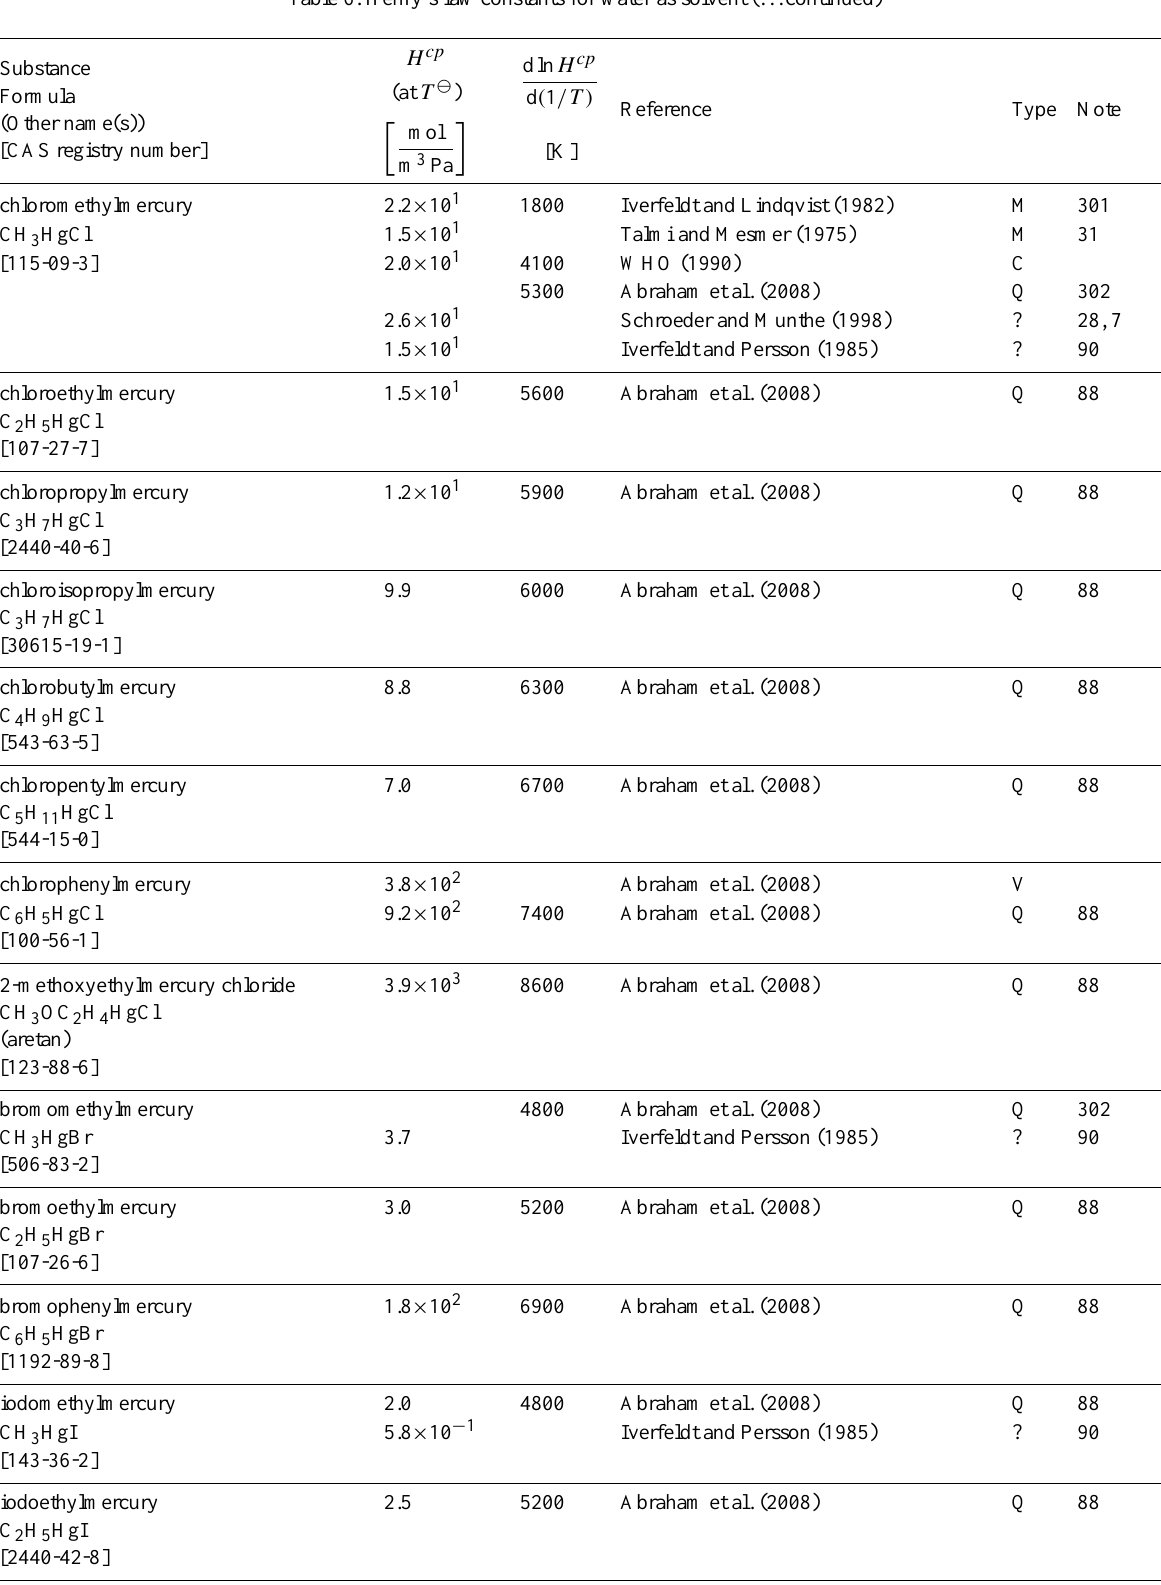
Table 6: Henry’s law constants for water as solvent